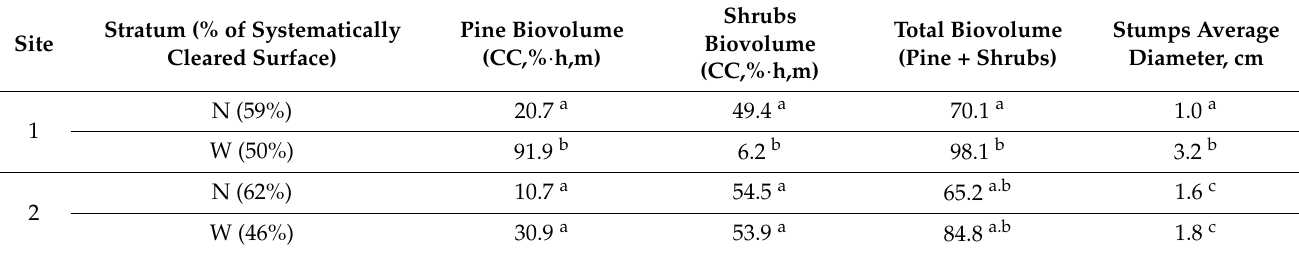
Table 2. Biobaler stratum characteristics (the different superscript letters indicate statistically significant differences at 95% probability). Acronyms: N, narrow; W, wide; CC, crown cover; h, height.